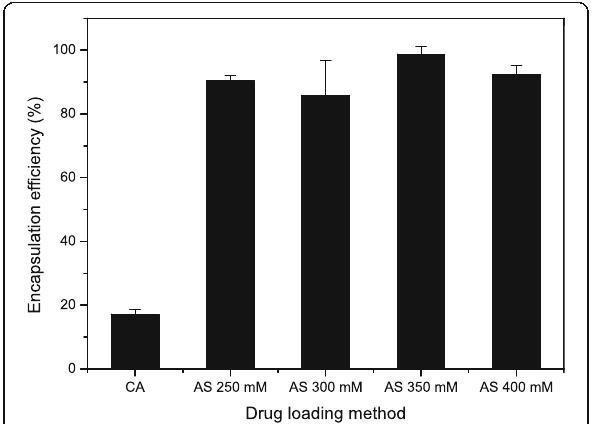
Fig. 4 Encapsulation efficiency of DOX in dual drug-encapsulated nanoliposomes according to DOX-loading methods and ammonium sulfate (AS) concentrations: CA citric acid ( n =3, the data are presented as mean±SEM)